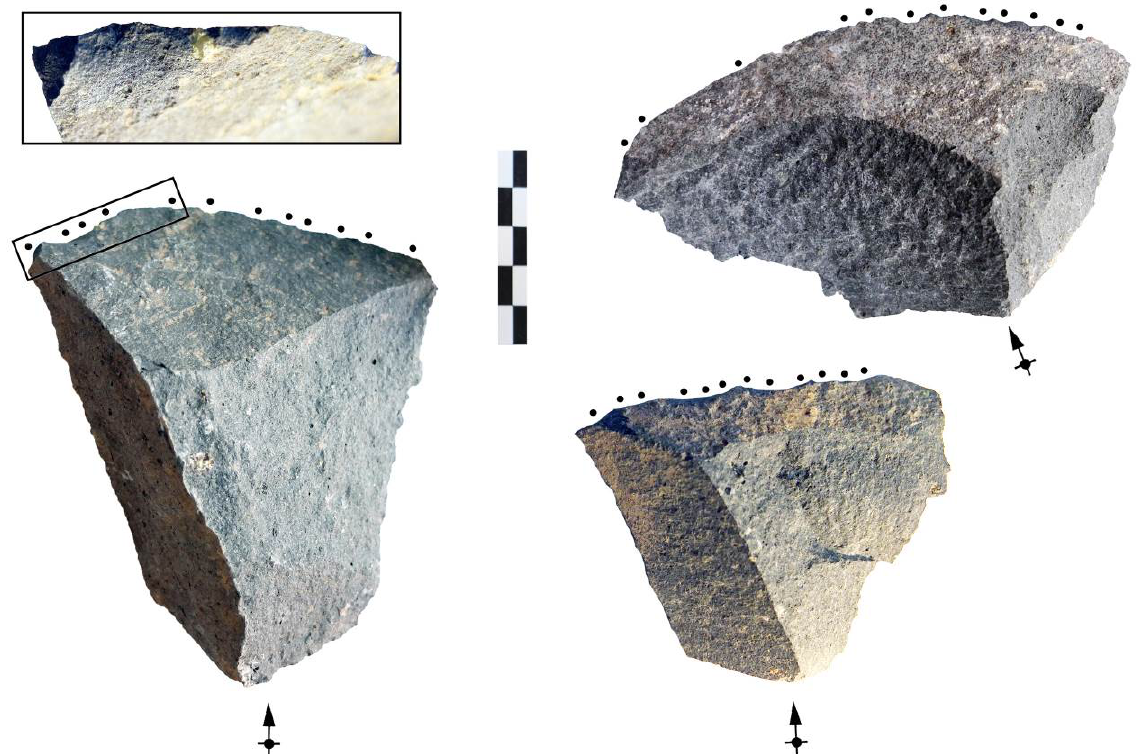
Figure 9. Retouches spontanées sur des éclats expérimentaux. Echelle de 5 cm (segments de 1cm) Figure 9. Spontaneous retouch on experimental flakes. The scale bar in the image is 5 cm wide (separated into 1 cm